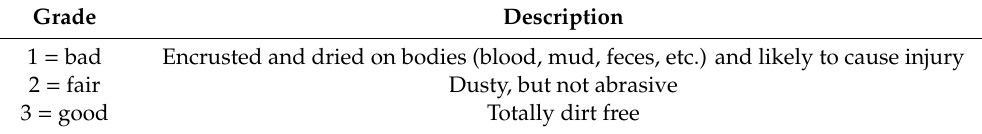
Table 2. Harness cleanliness scores.